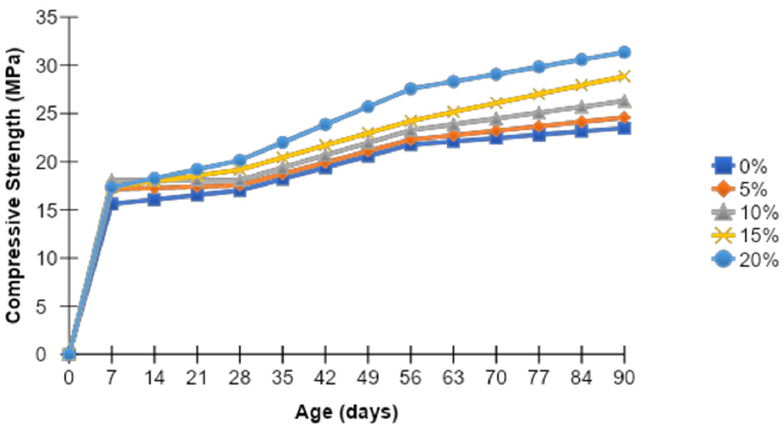
Figure 7. Comparison of rate of gain of compressive strength (combined) for all mixes.